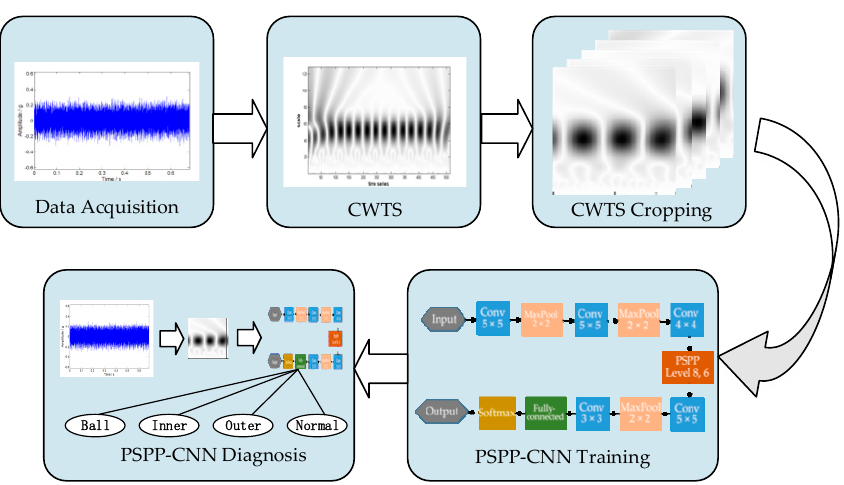
Figure 1. Flow chart of proposed fault diagnosis method. CWTS represents Continuous Wavelet Transform Scalogram, and PSPP-CNN represents Pythagorean Spatial Pyramid Pooling Convolutional Neural Network.